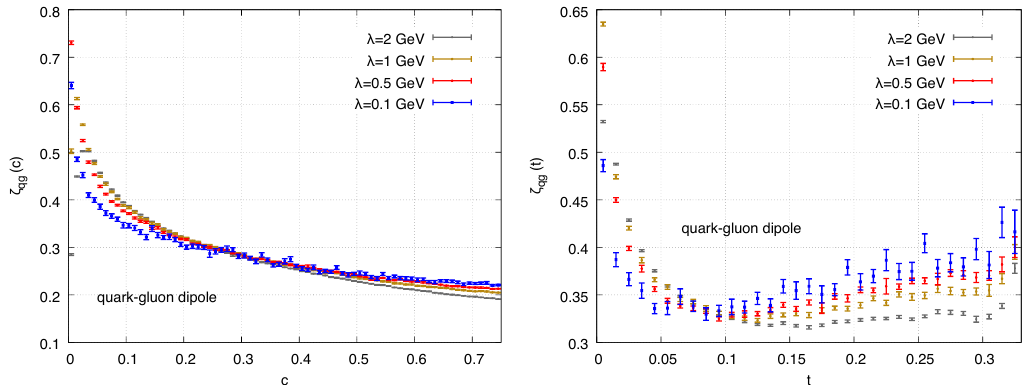
Figure 5 . The functions ζ qg ( c ) and ζ qg ( t ) for the C -parameter and for thrust t = 1 − T , obtained using Q = 100 GeV and λ = 2 GeV, λ = 1 GeV, λ = 0 . 5 GeV and λ = 0 . 1 GeV. See text for